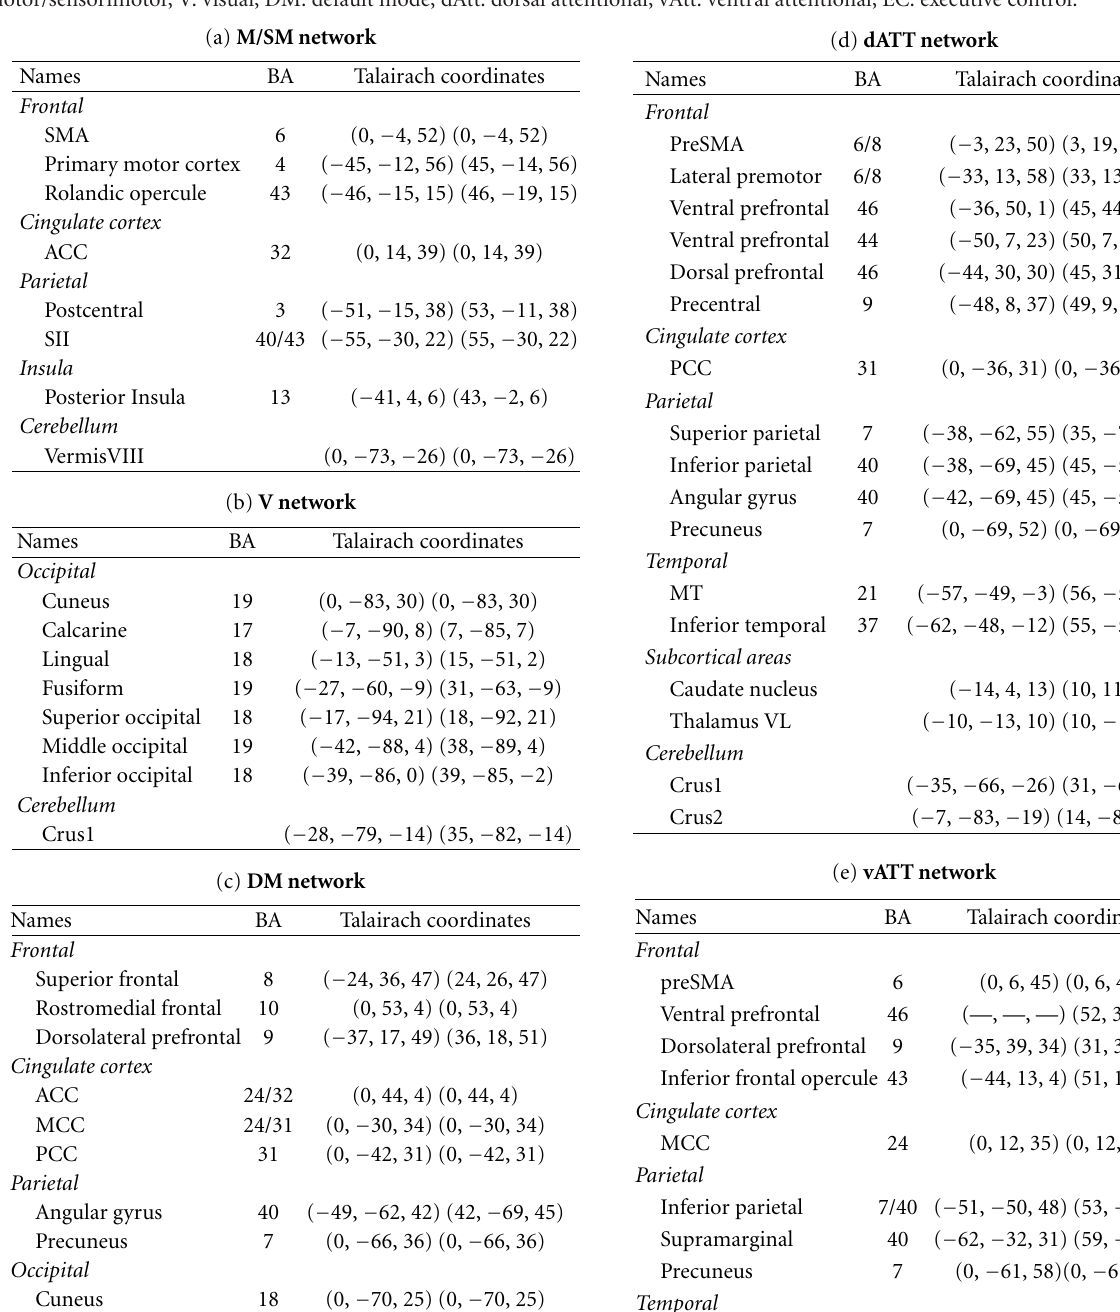
Table 2: Example of extended large-scale networks extracted in fMRI at rest. Peak foci corresponding to the six networks identified using spatial ICA and a hierarchical clustering approach similar to that of [79] on a group of 20 healthy subjects acquired at rest—M/SM: motor/sensorimotor, V: visual, DM: default mode, dAtt: dorsal attentional, vAtt: ventral attentional, EC: executive